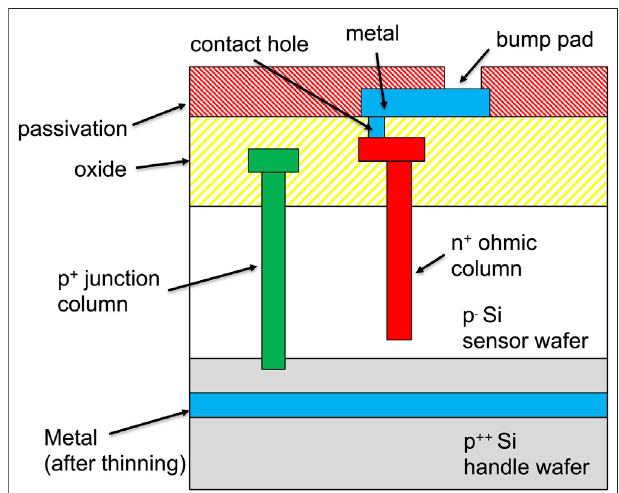
FIGURE 2 | Schematic cross section of 3D pixels made from Si-on-Si bonded wafers. All the columns are etched from the top side. The handle wafer is thinned down to the desired thickness before depositing the metal on the